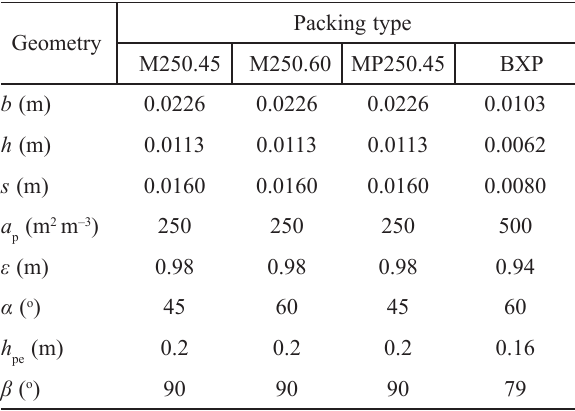
Table 2 – Geometric features of structured packings consid- ered in this study Packing type Geometry